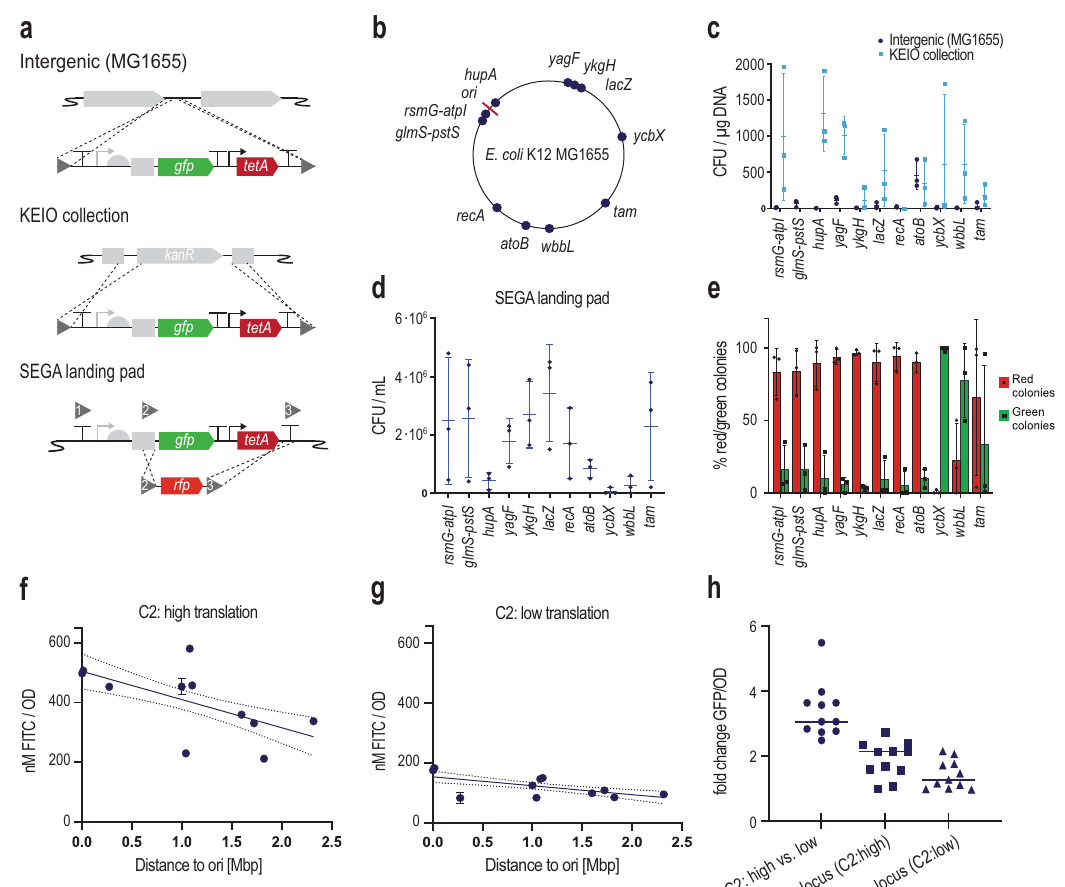
Fig. 5 Chromosome position affects integration ef fi ciency and gene expression. a Engineering of 11 different chromosome locations was tested using three different integration methods. Non-disruptive, intergenic integration in K12 MG1655 was compared with exchanging the kanR cassette in the BW25113 derivates of the Keio collection and cargo exchange within the SEGA landing pad. All results shown in panels f – h are based on intergenic, non- disruptive integrations. b Overview of the 11 engineered genome locations. c Integration ef fi ciency of intergenic integration as well as into the Keio collection, in which case the homology sequences are identical for all genomic locations. d Integration ef fi ciencies of rfp into the SEGA landing pad across different chromosomal locations. Ef fi ciencies are given in CFU per mL of the overnight recovery culture. e Ratio of true positive and false-positive colonies after recombination using the SEGA approach in different loci. f Constitutive GFP expression (C1: J23100, C2: high, BCD gadget) in 11 genome loci in late exponential growth phase in relation to the distance to the origin of replication (ori). The result of a linear regression analysis is shown with a 95% con fi dence interval. g GFP expression in 11 genome locations as in ( e ) but with C2: low. h The fold change of GFP fl uorescence between C2: high and C2: low strains measured for 11 genome locations. The fold change in GFP fl uorescence was also measured for each genome location compared to the lowest expressing locus with the same C2 element. The line represents the median fold change across 11 genome locations. In panels ( c ) – ( g ), the data represent the mean of three biological replicates with standard deviations. Source data are provided in the source data fi